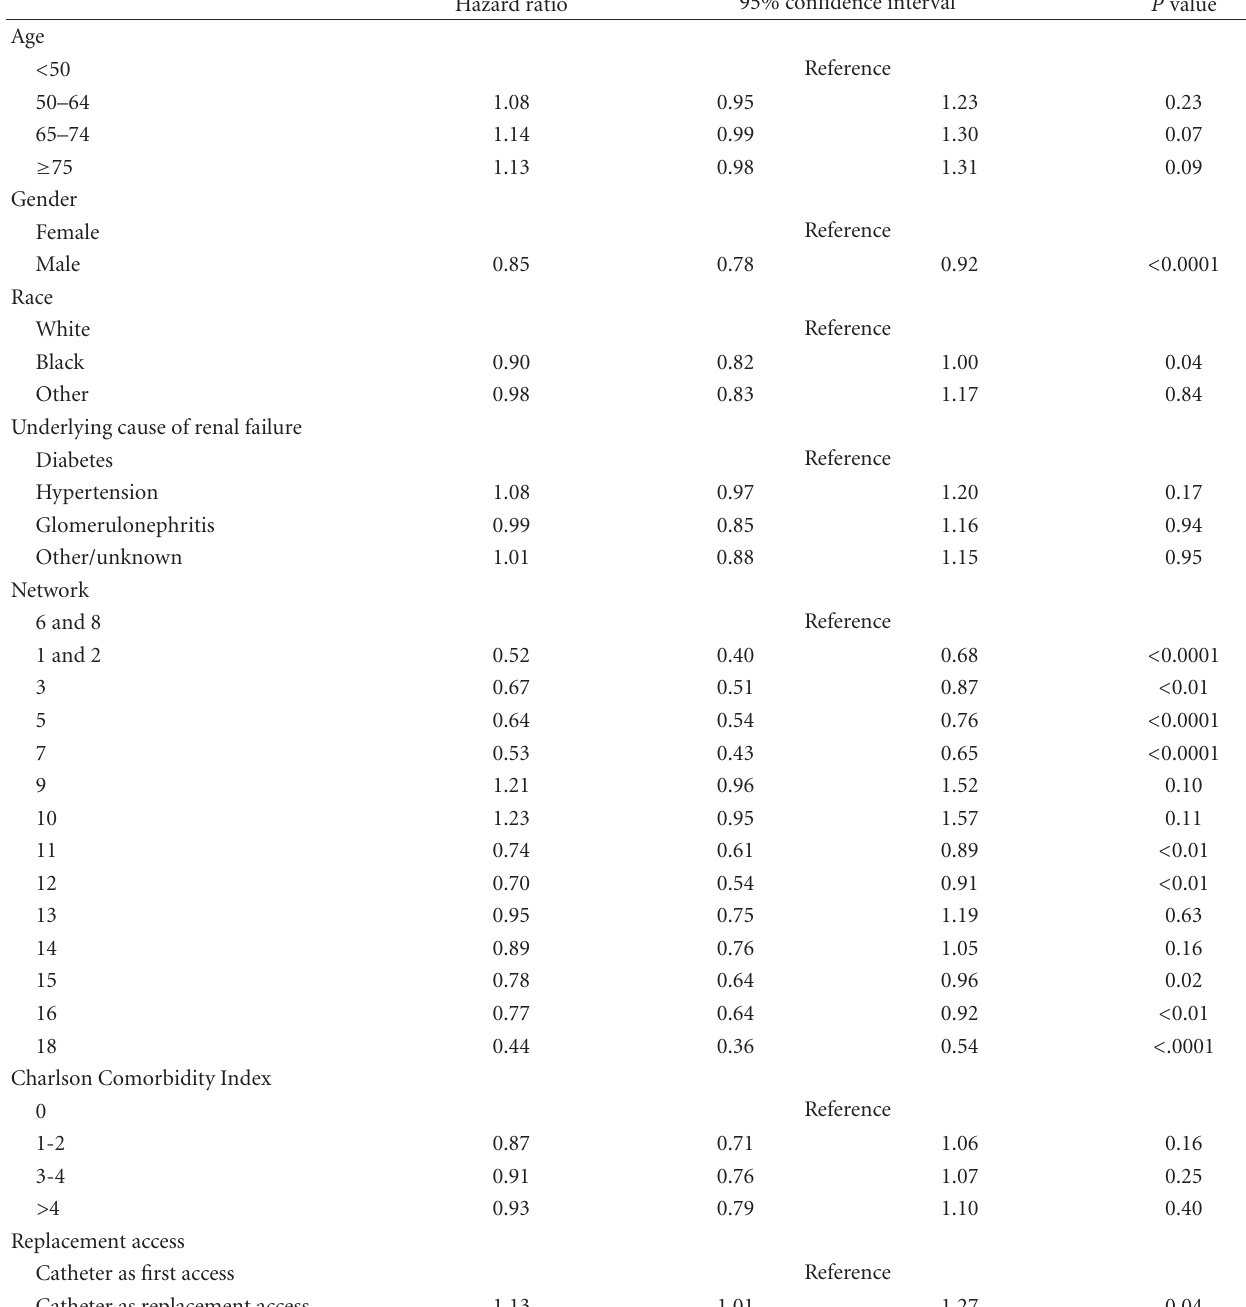
Table 3: Factors associated with catheter dysfunction ∗